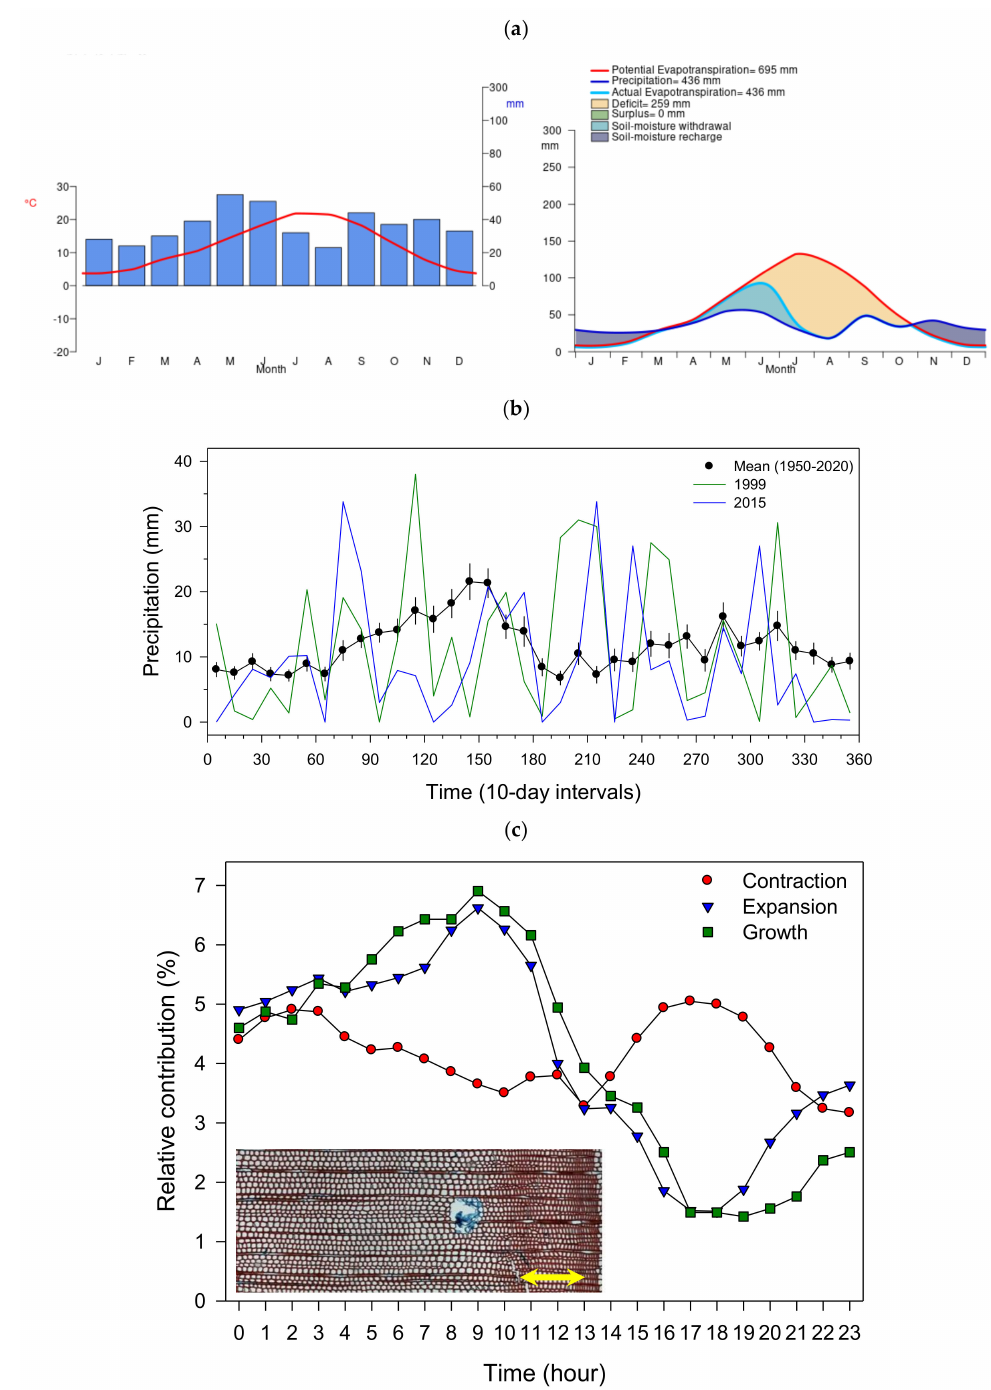
Figure 1. Temporal scales (month, 10-day intervals, hours) considered in the study of climate–IADFs relationships. Correlations were calculated considering ( a ) monthly, ( b ) 10-day, and ( c ) hourly climate data. In plot ( a ) the climate diagram of Daroca station showing typical Mediterranean conditions is presented with estimates of monthly potential evapotranspiration. In plot ( b ) symbols show mean ( ± SE) precipitation values and color lines show precipitation values in this station for years with a high frequency of IADFs (1999, 2015). In plot ( c ) the hourly phases of stem contraction, expansion, and assumed growth were obtained from dendrometers attached to a P. halepensis tree in the Peñaflor site (see Table 1). The image in ( c ) shows a latewood IADF (yellow arrow) in a cross-section showing an annual ring of P. halepensis